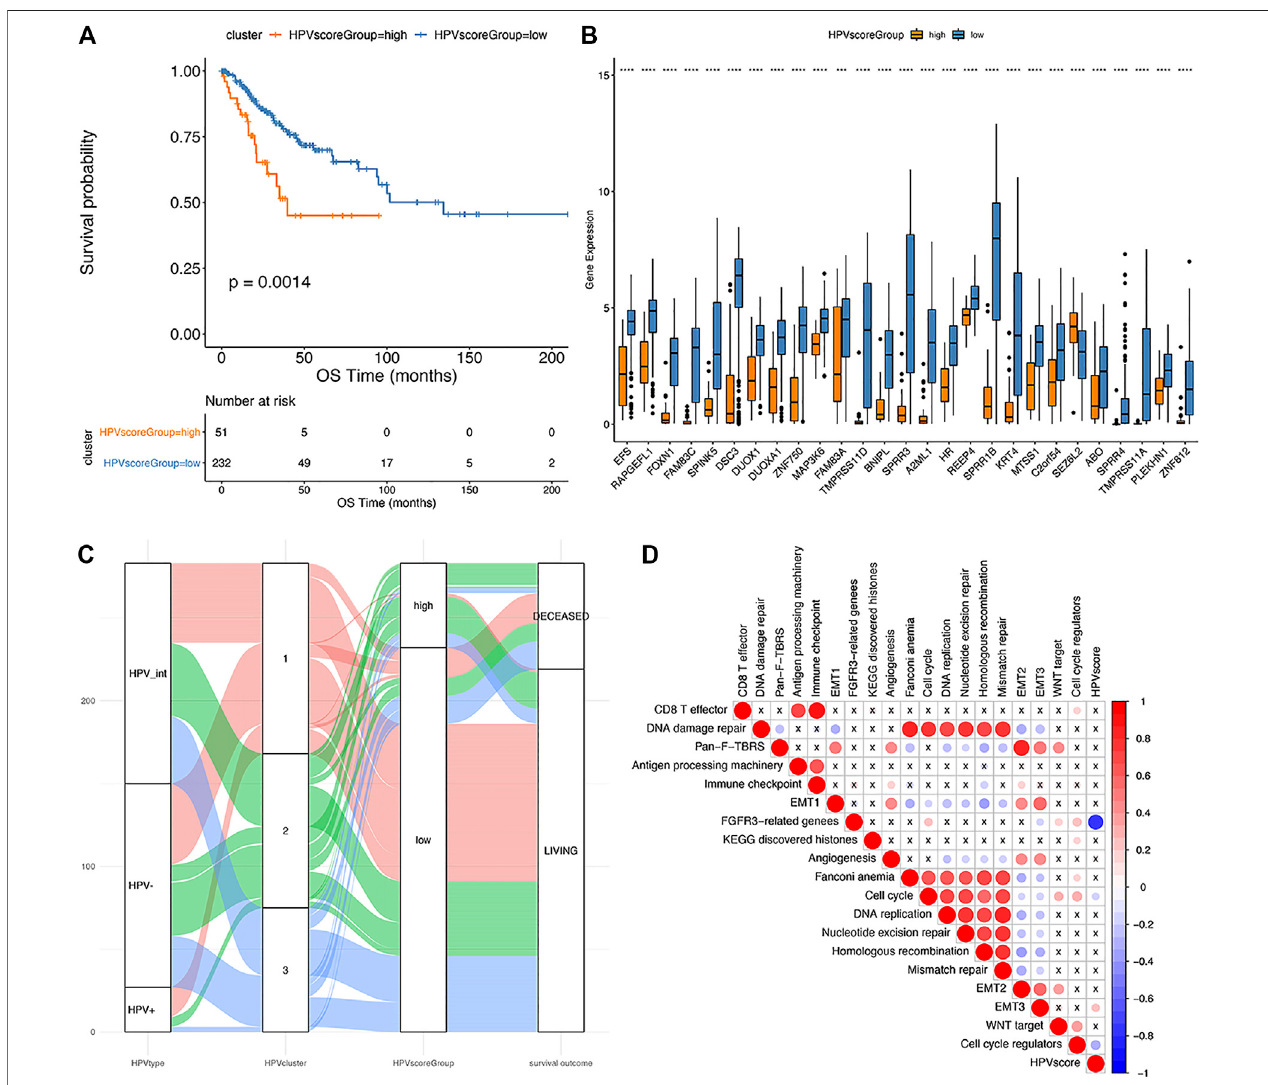
FIGURE 7 | The establishment of HPV score system. (A) : Kaplan-Meier analysis of overall survival in cervical cancer patients strati fi ed by HPV score; (B) : The expressionofHPVscoreassociatedgenesindifferentHPVscoregroups(signi fi canceanalysisby t -test); (C) :ThealluvialplotshowingthecorrelationamongHPVstatus, iClusterclusteringand HPV score; (D) : Pearson analysis ofHPV score and its associatedgenes(The negativecorrelation ismarkedin blue and positively correlated with red. The X in the graph indicates that the correlation is not signi fi cant, and the larger the circle is, the more signi fi cant the correlation is).